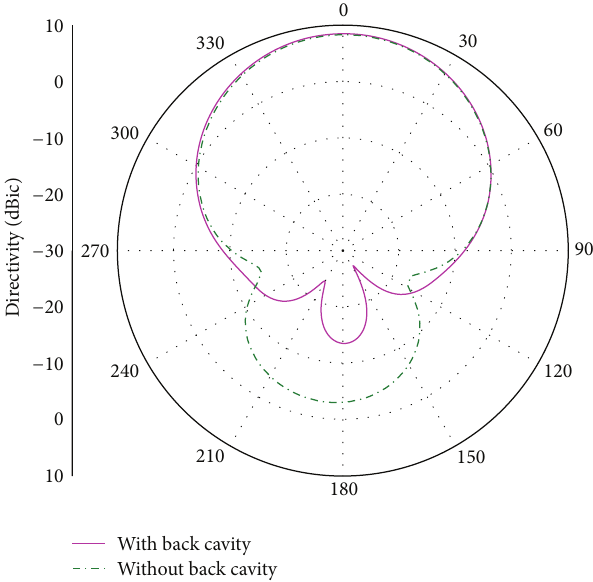
Figure 8: The simulated radiation pattern with and without back